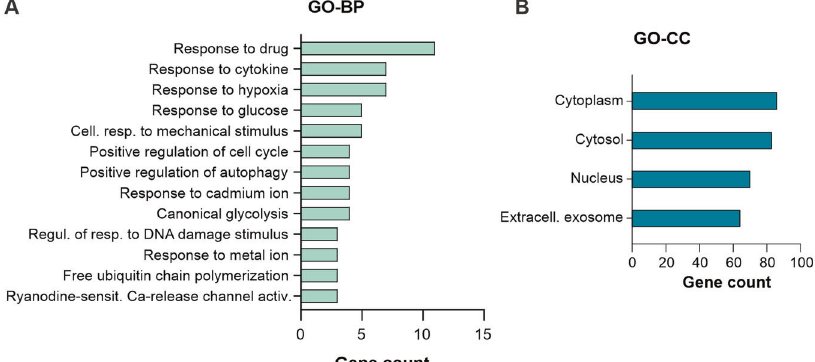
Fig. 5 Proteomics enrichment analysis for torin2. Bar chart showing the number of proteins upregulated by torin2 that cluster for Gene Ontology (GO) terms for Biological Process (BP) ( A ) and Cellular Component (CC) ( B ) with a log p -value of p < 10 − 3 .